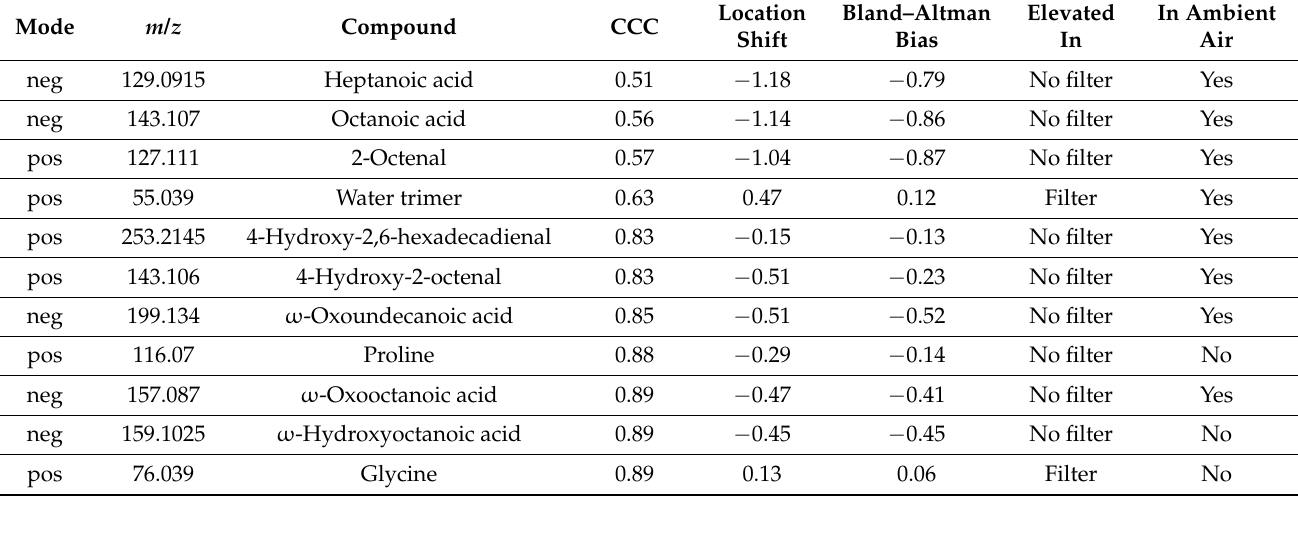
Table 1. Exhaled metabolites with a CCC < 0.9. The location shift and Bland–Altman bias indicate whether the intensity was increased (positive values) or decreased (negative values) with filter usage.